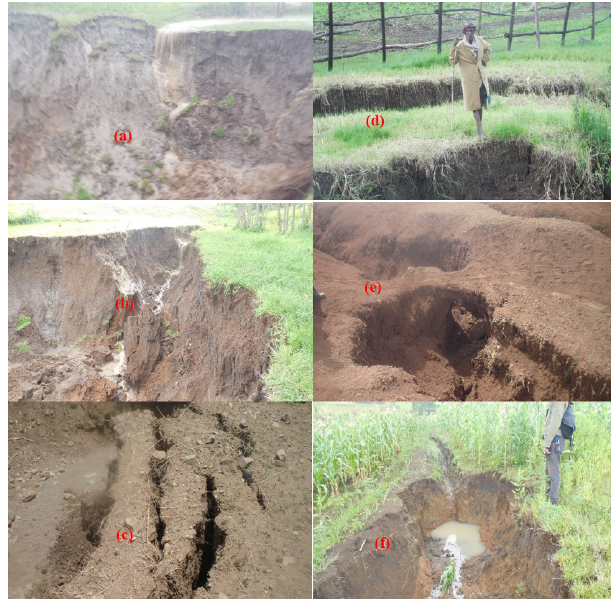
Figure 1. Examples of gully expansion controlled by (a, b) bank geometry (height and slope), (c) tension cracks, (d) landslide, (e) soil pipes, and (f) saturated Vertisols (gully development on con- servation ditches, narrow ditch upstream of gully headcut) in the subhumid Debre Mawi (a, b, d, f) , Mota (c) , and Geregera (e) wa- tersheds (pictures taken in